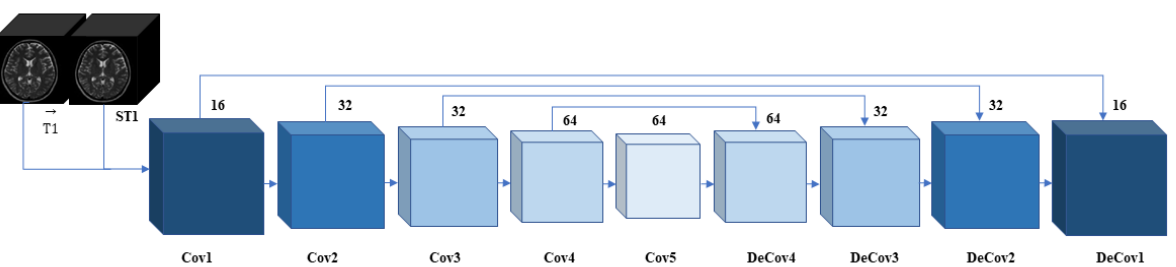
Figure 5. The detailed construction of our